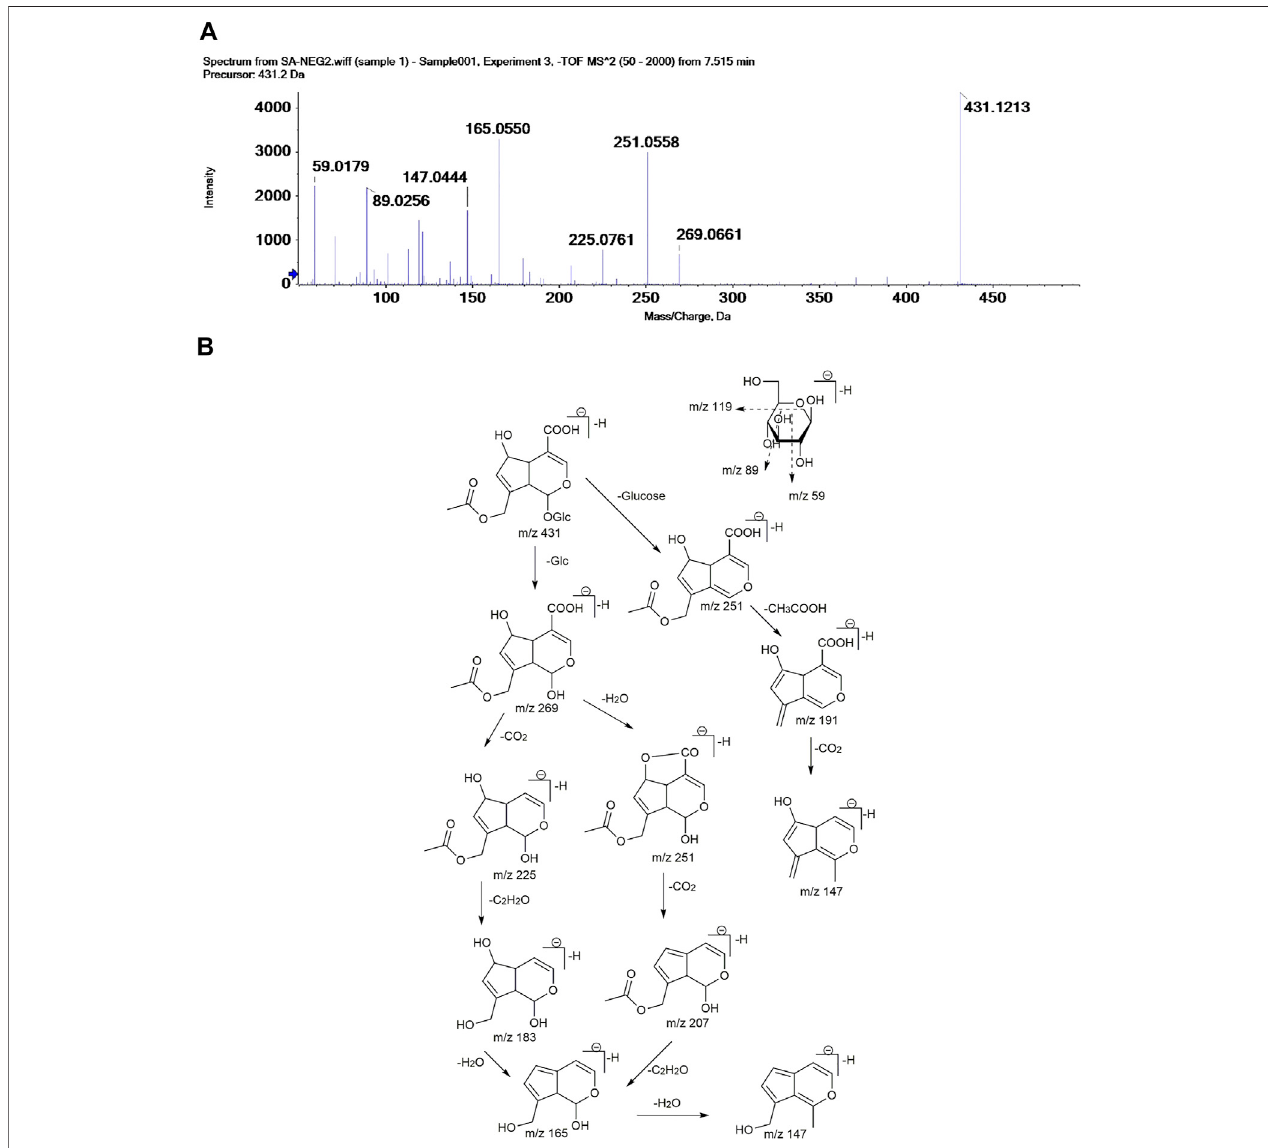
FIGURE 4 | MS/MS spectra (A) and the proposed fragmentation pathway (B) of asperulosidic acid.